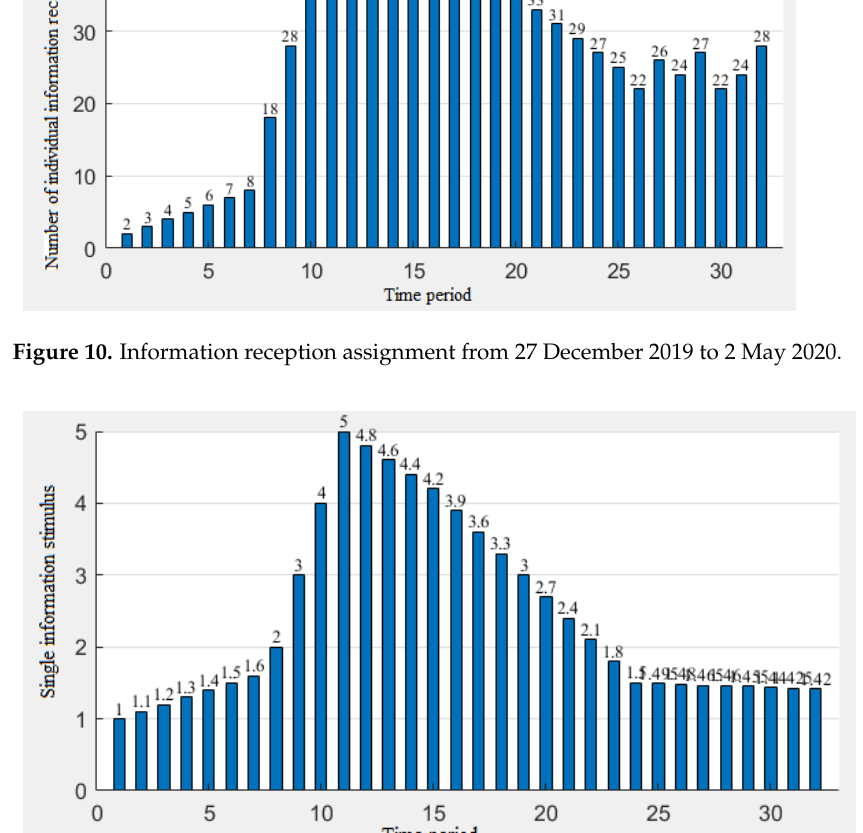
Figure 12. Risk perception changes from 27 December 2019 to 2 May 2020.